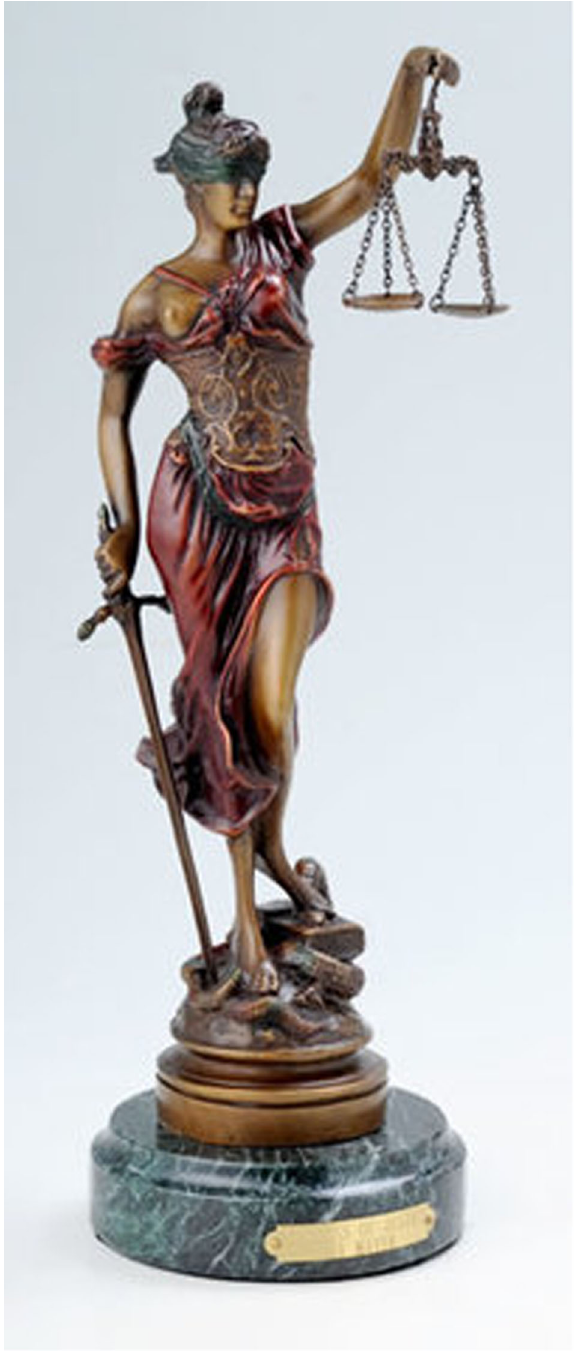
Fig. 1 Themis, the Greek goddess of justice, installed in courthouses and law of fi ces, is considered the ‘ guardian of justice and order ’ . She wears a blindfold as a sign of her objectivity and sel fl essness, holding a sword in her right hand to protect society from vice and a ‘ balance of justice ’ in her left hand to measure right and wrong. This photograph was reprinted with the permission of the copyright holder, the Nippon Catalogue Shopping Co.